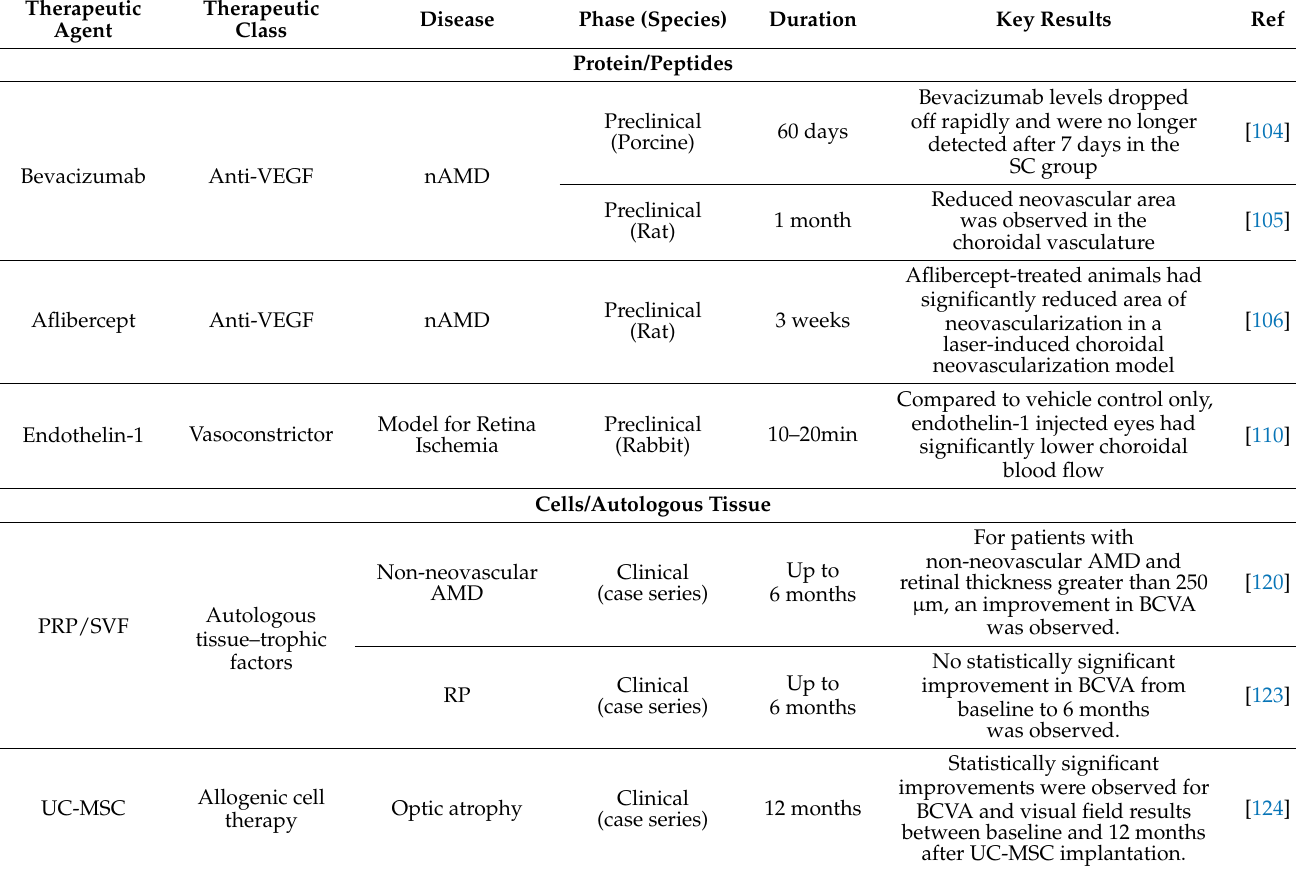
Table 5. Summary of Preclinical and Clinical Investigations of Proteins, Peptides, and Cells Administered into the Suprachoroidal